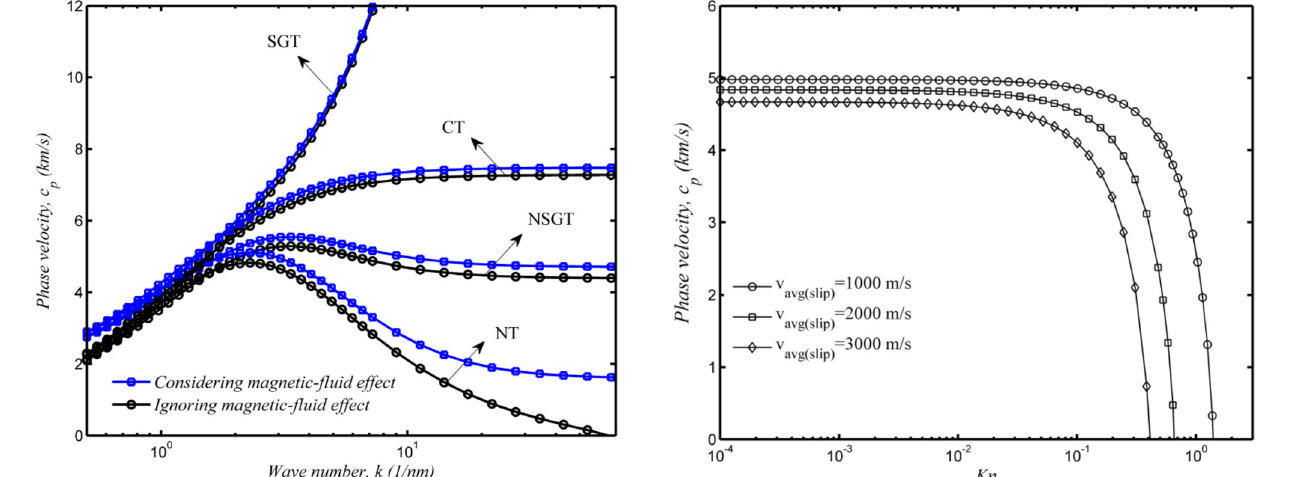
Table 1 The values for physical parameters of CNT [6] Physical properties and